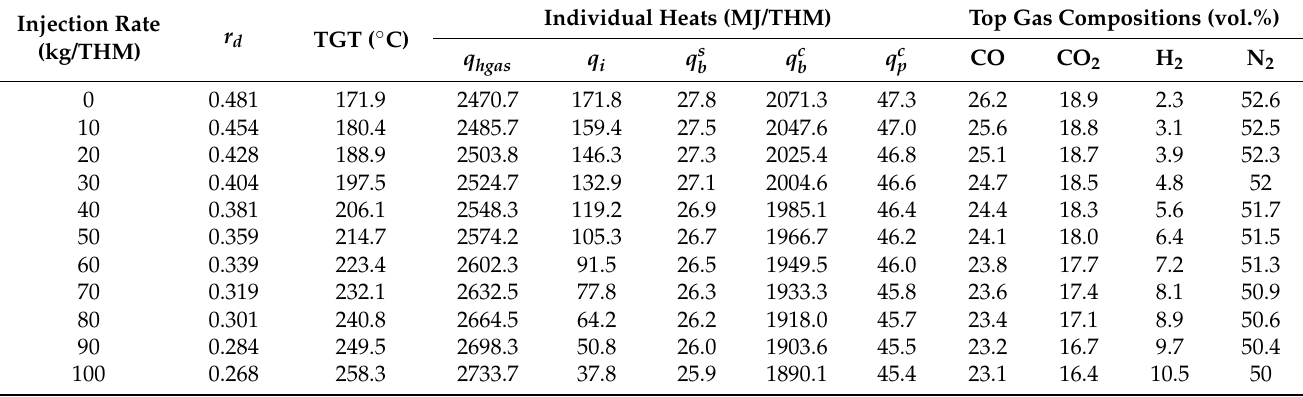
Table A2. Relevant parameter values in the calculation of TGT (injection of coke oven gas).